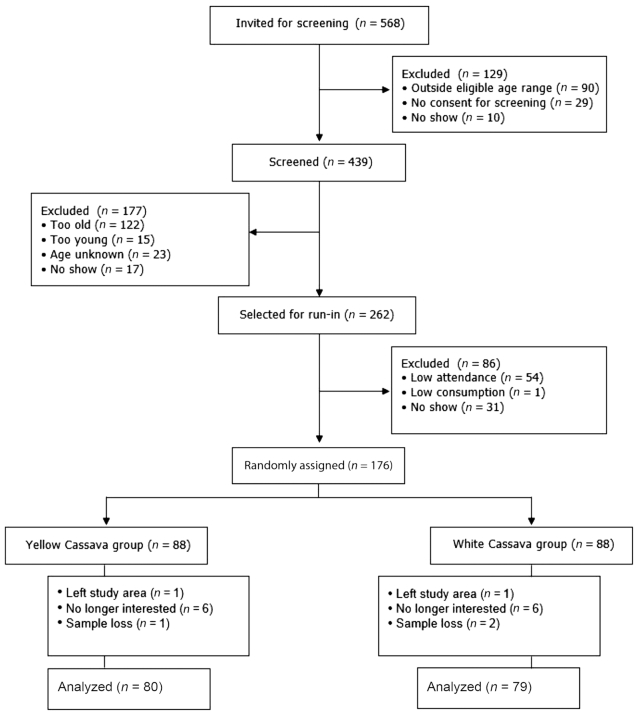
Study flow diagram.